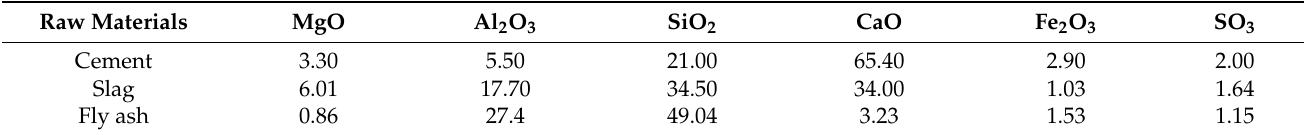
Figure 1. Photos of raw materials. Table 2. Chemical composition of raw materials.